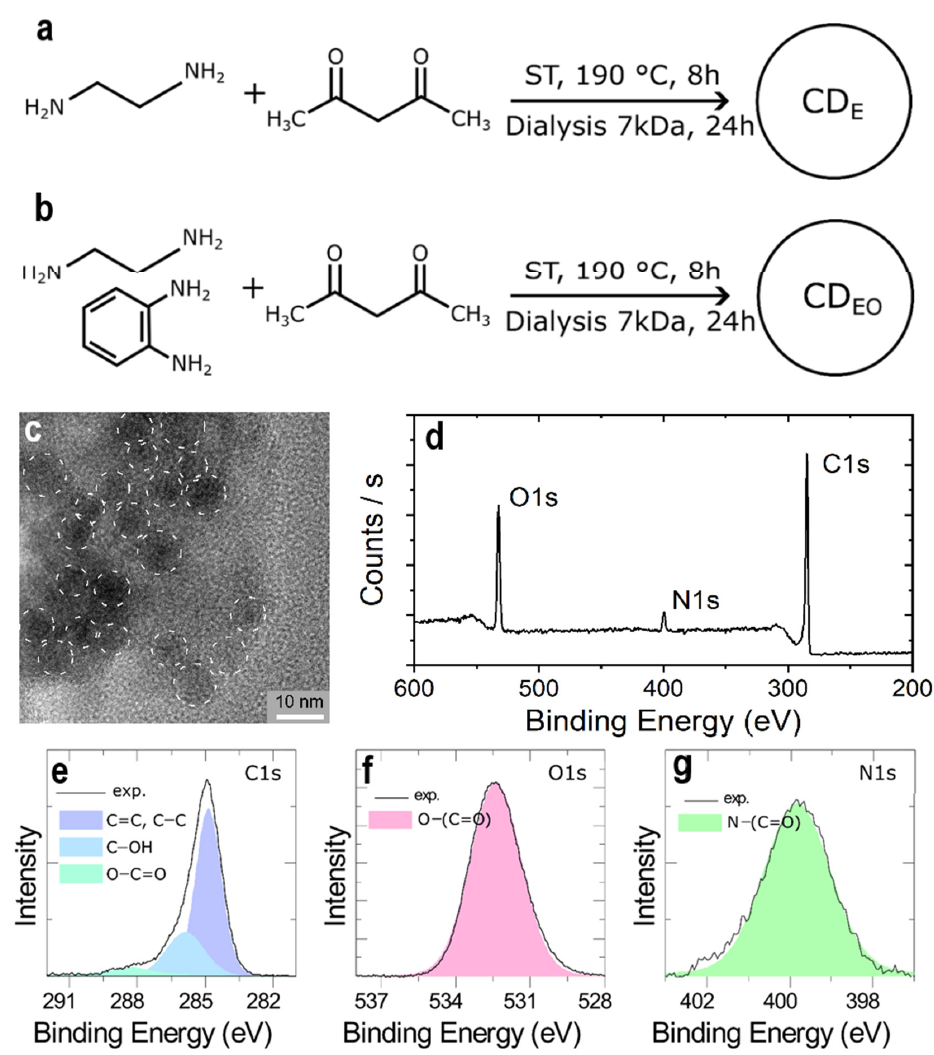
Figure 1. Schematic representation of CD E ( a ) and CD EO ( b ) synthesis. ( c ) Typical TEM image obtained for CD E. Full survey XPS spectrum ( d ) and corresponding high-resolution XPS spectra for carbon ( e ), oxygen ( f ), and nitrogen ( g ) elements obtained for CD E.